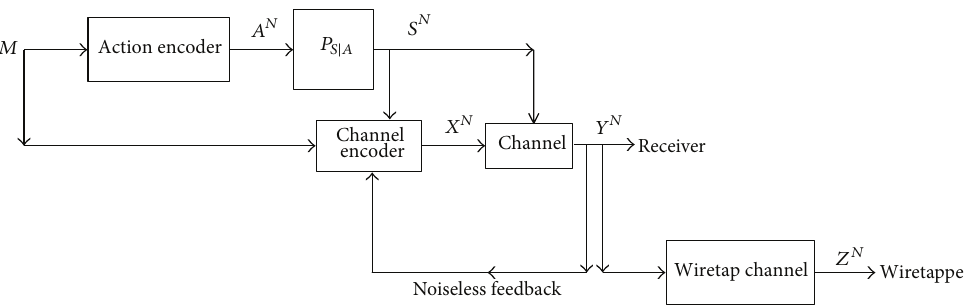
Figure 6: Wiretap channel with action-dependent channel state information and noiseless